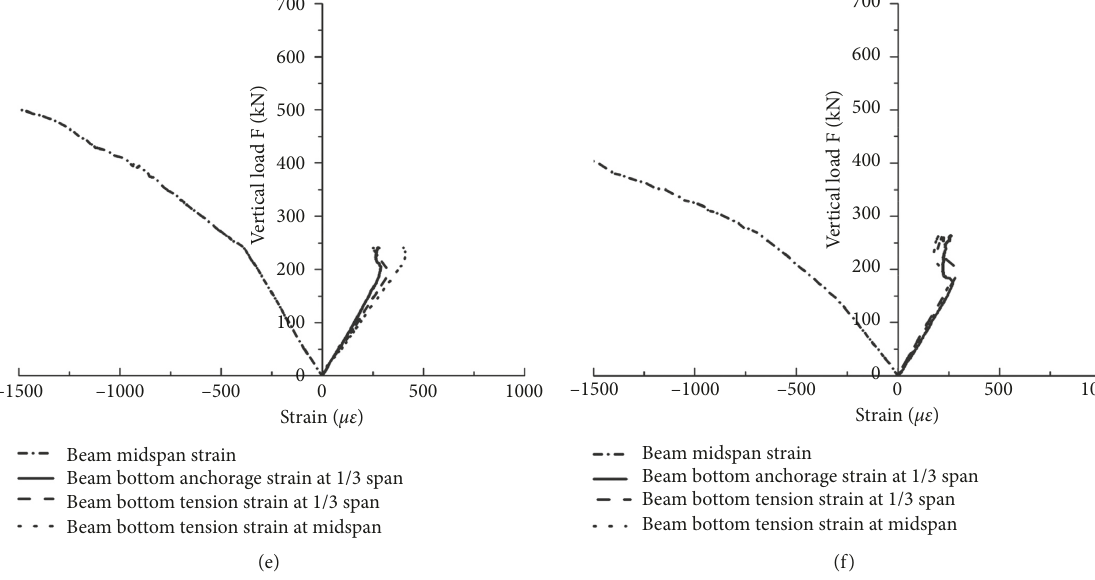
Figure 11: Changes in strain under load at cross sections at girder midspan and ⅓-span. (a) PC 1-0-0. (b) PC 2-0-6. (c) PC 3-0-8. (d) PC 4-0-9. (e) PC 5-6-8. (f) PC 6-8-8.